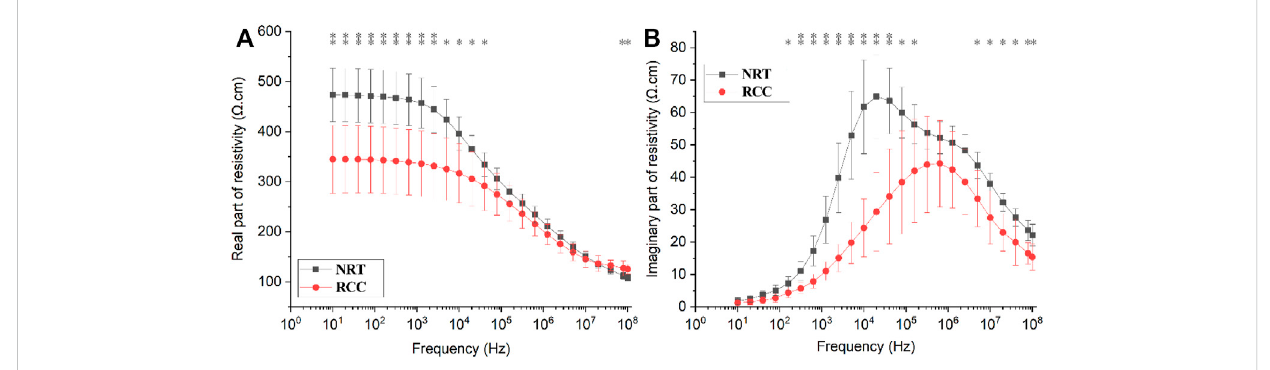
FIGURE 3 Changesinthe (A) realpart( ρ re)and (B) imaginarypart( ρ im)ofresistivityofnormalrenaltissue(NRT)andrenalcellcarcinoma(RCC)withfrequency. * p < 0.05, ** p < 0.01.